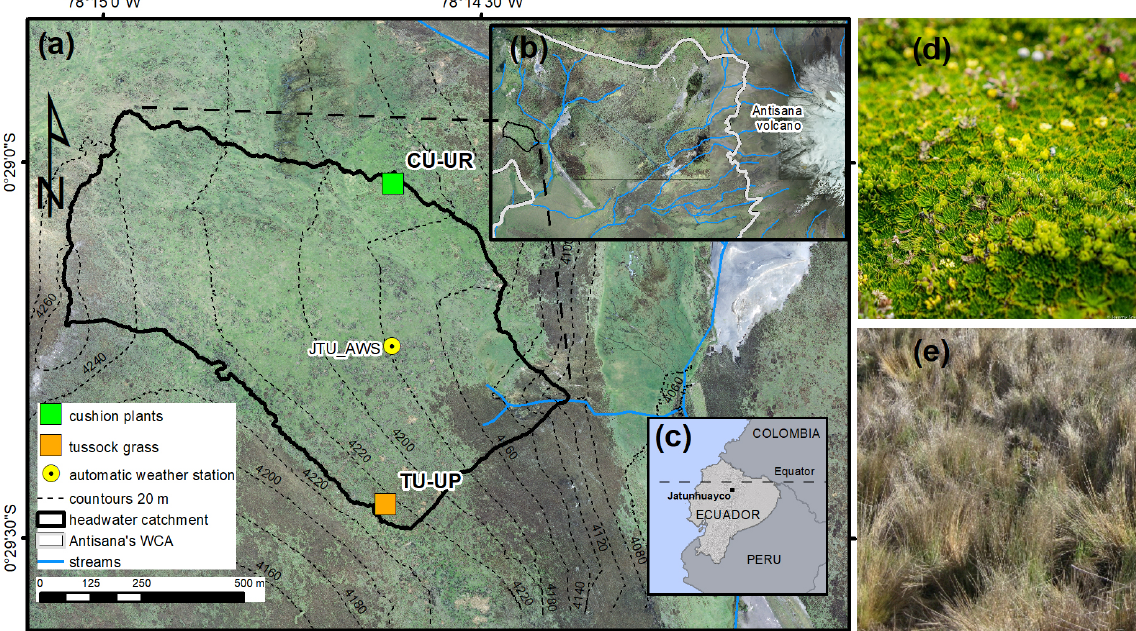
Figure 1. (a) Soil profiles CU-UR and TU-UP within the Jatunhuayco catchment, (b) Antisana’s Water Conservation Area (WCA), (c) locations of study sites in Ecuador, (d) cushion-forming plants and (e) tussock grass. (Orthophotos from SIGTIERRAS, Ministerio de